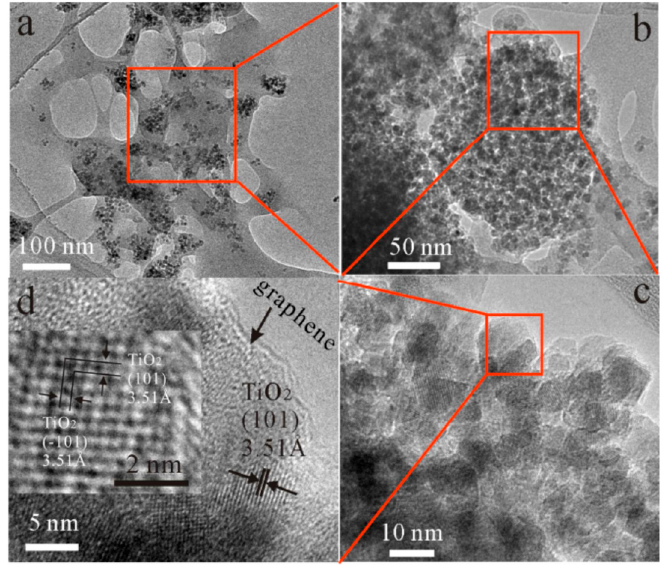
Figure 1. ( a, b ) TEM and ( c, d ) HR-TEM images of G 2.5 -TiO 2 nanocomposite. From Ref. [35]. Reprinted with permission from American Chemical Society (ACS).